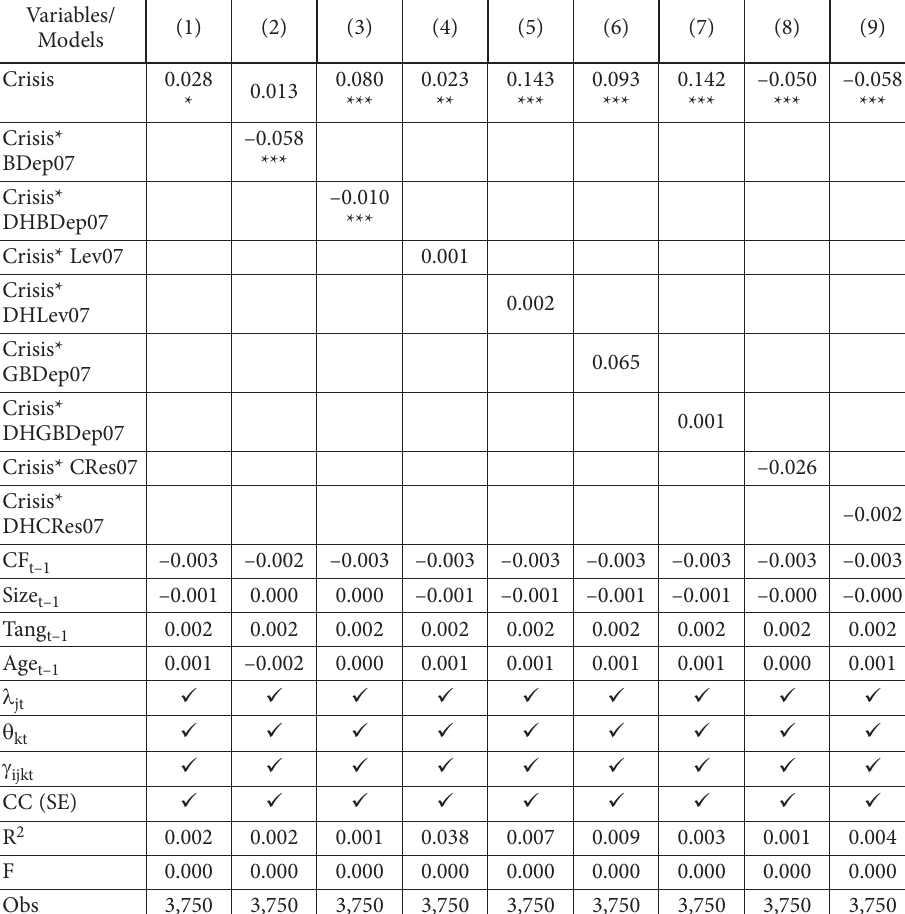
Table 4. Changes in investment in long term